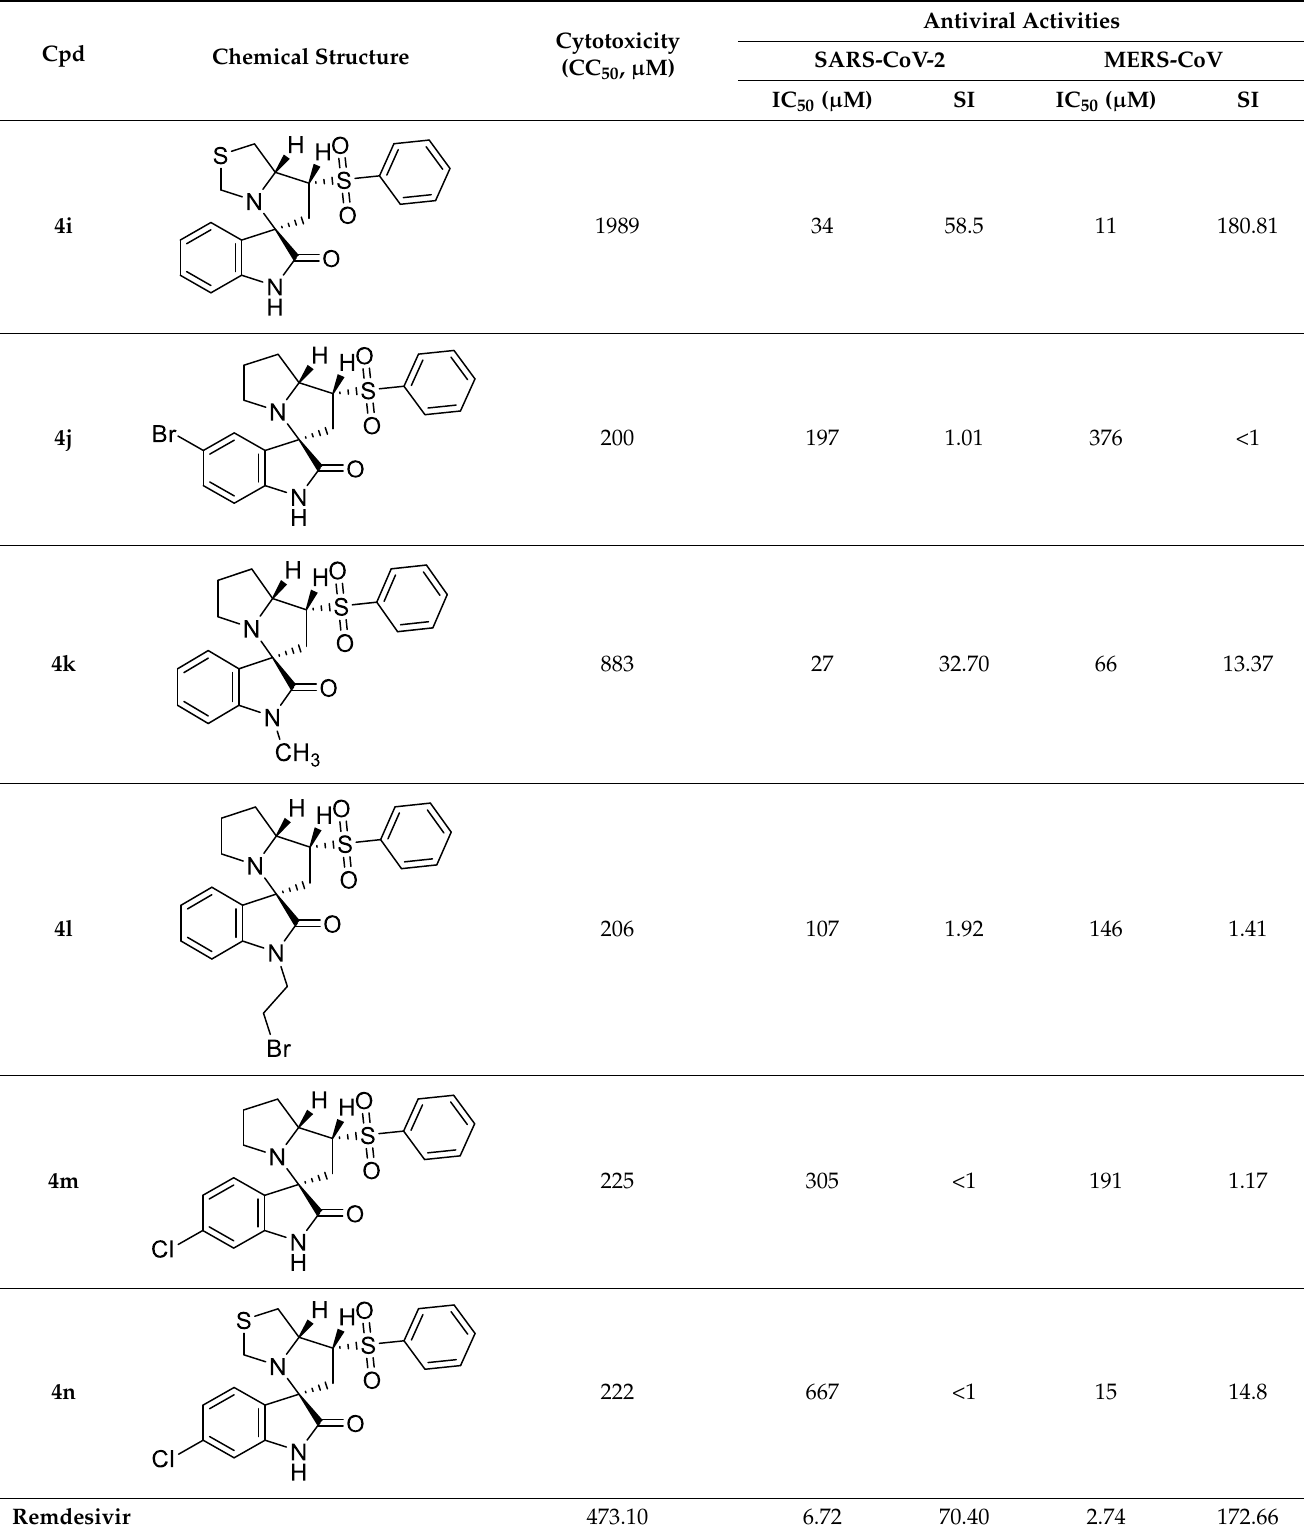
Abbreviations: “Cpd” , Compound; “CC 50 ” , half maximal cytotoxic concentration; “IC 50 ” , half maximal inhibitory concentration; “SI” , Selectivity index; Remdesivir as a drug control.